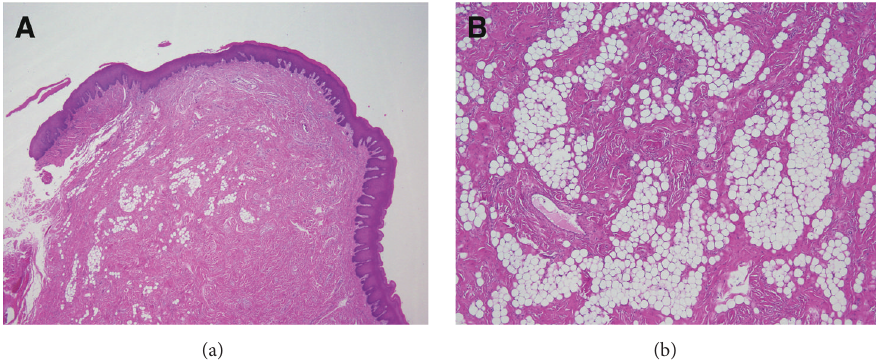
Figure 4: Histological findings of the lesion. (a) A histological examination showed that the lesion contained an overlying epithelium and adipose tissue within dense collagen fibers (hematoxylin and eosin stain, × 10) and (b) mature adipose tissue interspersed by broad bands of dense connective tissue ( ×